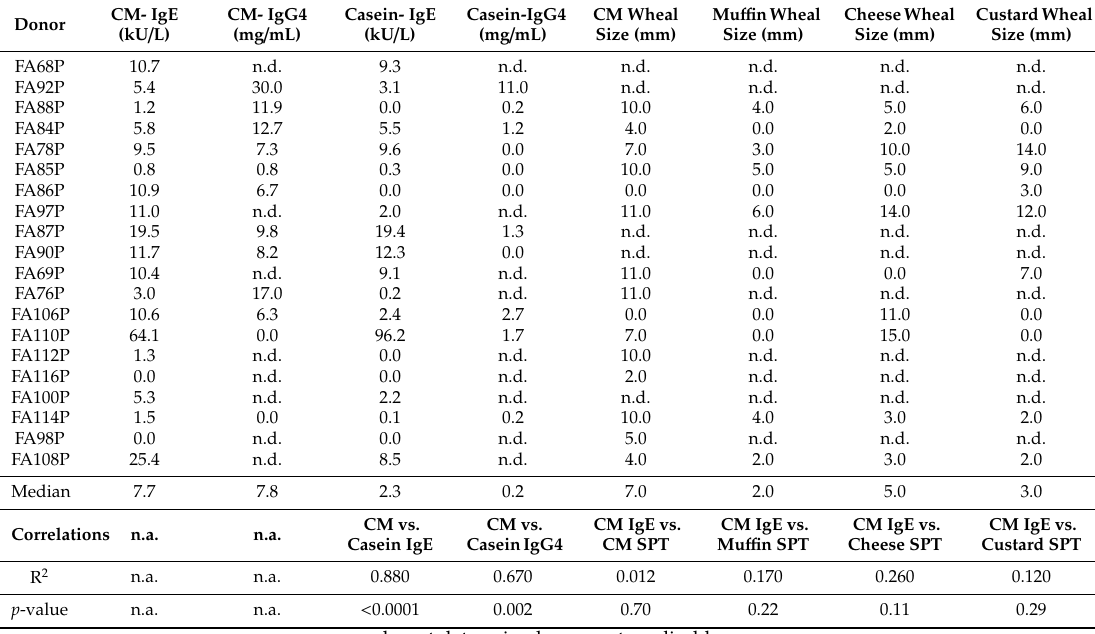
Table 2. Baseline allergy testing and test correlations for cow’s milk allergic